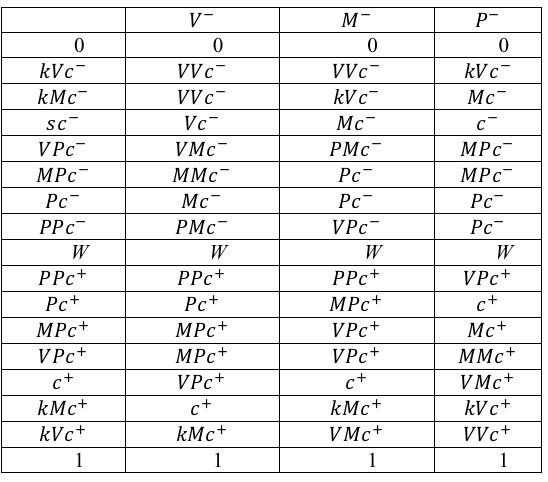
Table 1. Inverse mapping of